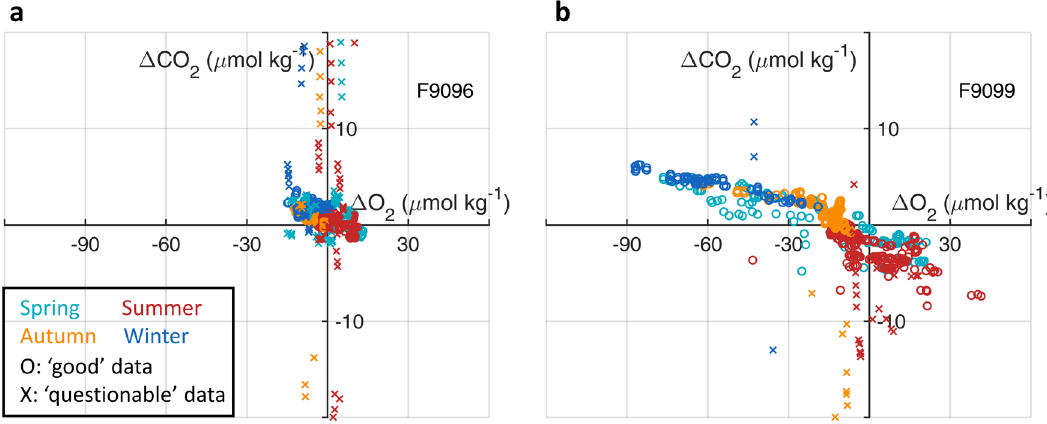
Fig. 5 CORS plots from data collected by SOCCOM fl oat F9096 and F9099 in the high-latitude Southern Ocean. a Float F9096, b fl oat F9099. Circle with solid edge denotes ‘ good ’ fl agged data, whereas cross denotes ‘ questionable ’ fl agged wintertime. Unlike Williams et al. 33 in Fig. 5 we have plotted both data fl agged as ‘ questionable ’ or ‘ bad ’ and data fl agged as ‘ good ’ . The fi gure shows some abnormally high (up to 20 µmol kg − 1 ) and low (down to − 20 µmol kg − 1 ) Δ CO 2 values, neither of which are coupled with equivalent Δ O 2 values. The resulting CORS plots are signi fi cantly different from the general CORS pattern across the global ocean (Fig. 4). All of these abnormal data have been fl agged ‘ questionable ’ or ‘ bad ’ by SOCCOM ’ s QC procedure but CORS plots also reveal the data to be problematic.